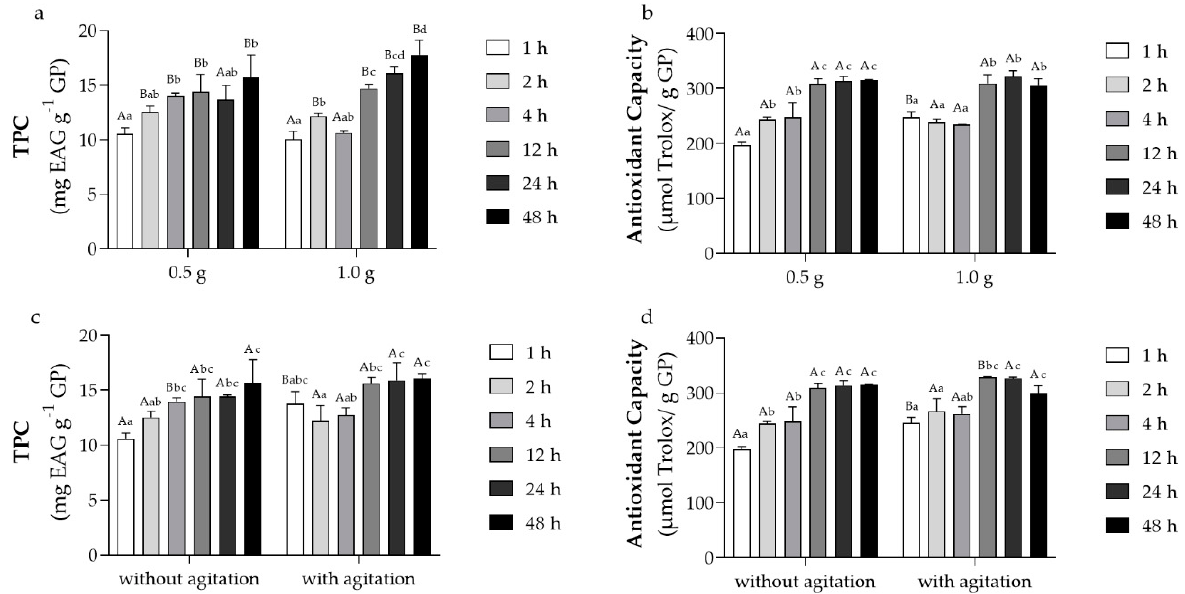
Figure 1. TPC and antioxidant capacity (ORAC-FL) of Carménère GP extract at different maceration times. Effects of GP masses ( a , b ) and agitation ( c , d ) during the extraction are presented. Means and standard deviations are shown. Different capital letters indicate significant differences ( p > 0.05) in the TPC or antioxidant capacity between masses or agitation at the same time. Different lowercase letters indicate differences ( p > 0.05) in the TPC and antioxidant capacity between different times at the same mass or agitation condition.